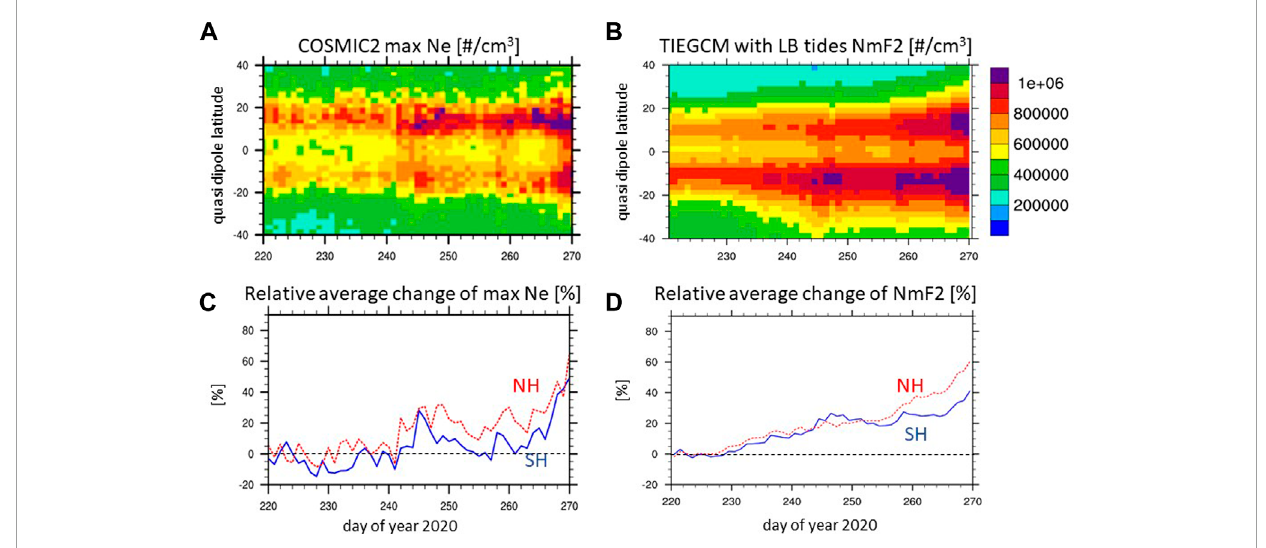
FIGURE 7 Top panels (A) . Median of maximum electron density from COSMIC2 RO (equivalent to NmF2) and (B) average of NmF2 from TIEGCM with LB tides [ 1 / cm 3 ] for binned values (bin size 1 day and 2 . 5 o quasi dipole latitude); bottom panels: relative change of quasi dipole latitudinal average between 5 o ≤ | λ qd | ≤ 20 o of (C) maximum electron density from COSMIC and (D) NmF2 from TIEGCM with respect to average latitudinal variation between DOY